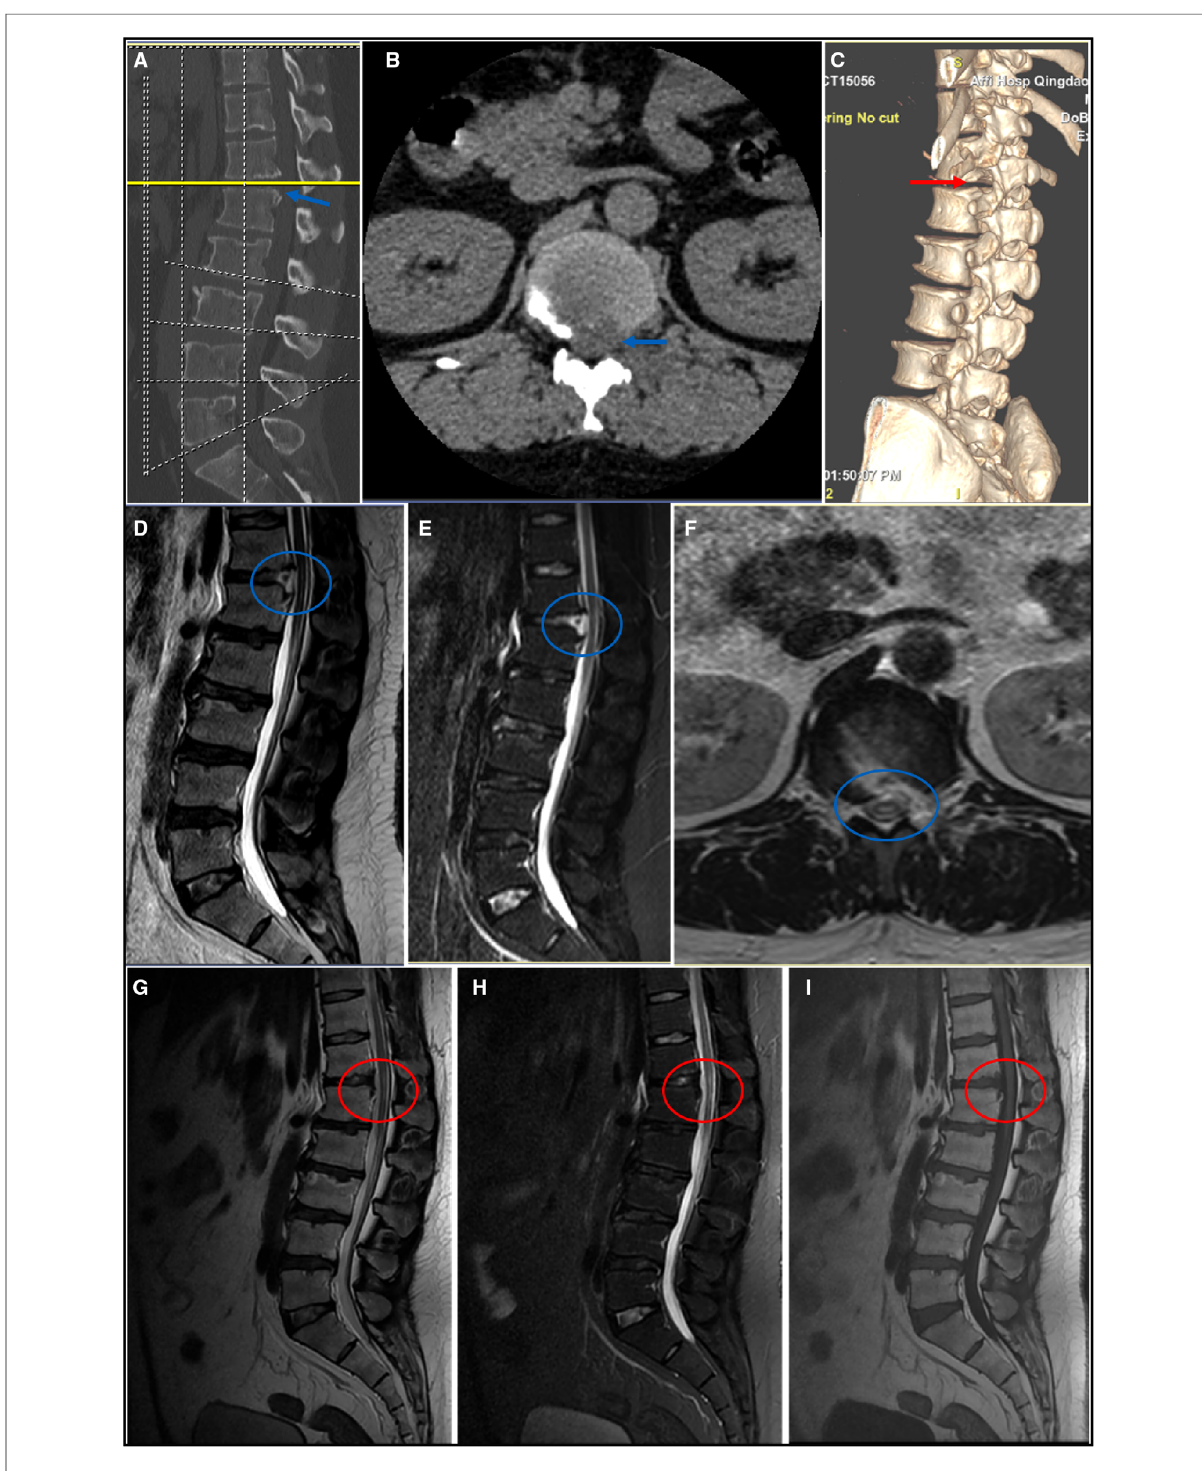
FIGURE 4 Postoperative imaging of the typical patient with disc herniation at the T12 – L1 level. ( A – C ) CT at 1 day postoperatively. The blue arrow shows suf fi cient removal of calci fi c herniated disc. The red arrow shows that the SAP is partly resected and the stability of the spine is preserved. ( D – F ) MRI at 1 day postoperatively. The blue circle shows complete decompression of dura sac with a small amount of fl uid signal in the ventral side of dura sac. ( G – I ) MRI at 6 months postoperatively. The red circle shows perfect decompression of dura sac and normal signal of cerebrospinal fl uid surrounding the dura. ( A,D,E,G – I ) sagittal view; ( B,F ) axial view; ( C ) three-dimensional reconstruction. SAP, superior articular process; CT, computed tomography; MRI, magnetic resonance